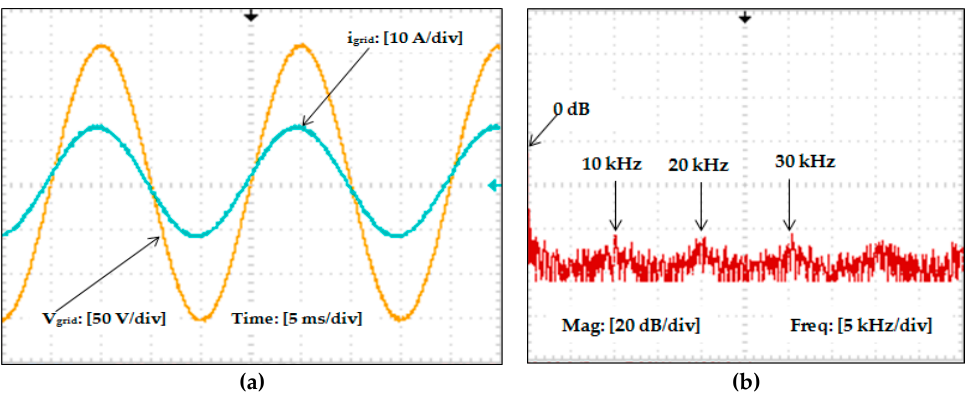
Figure 15. Experimental waveforms with Filter II: ( a ) output voltage and current waveforms; and ( b ) output current harmonic spectrum.